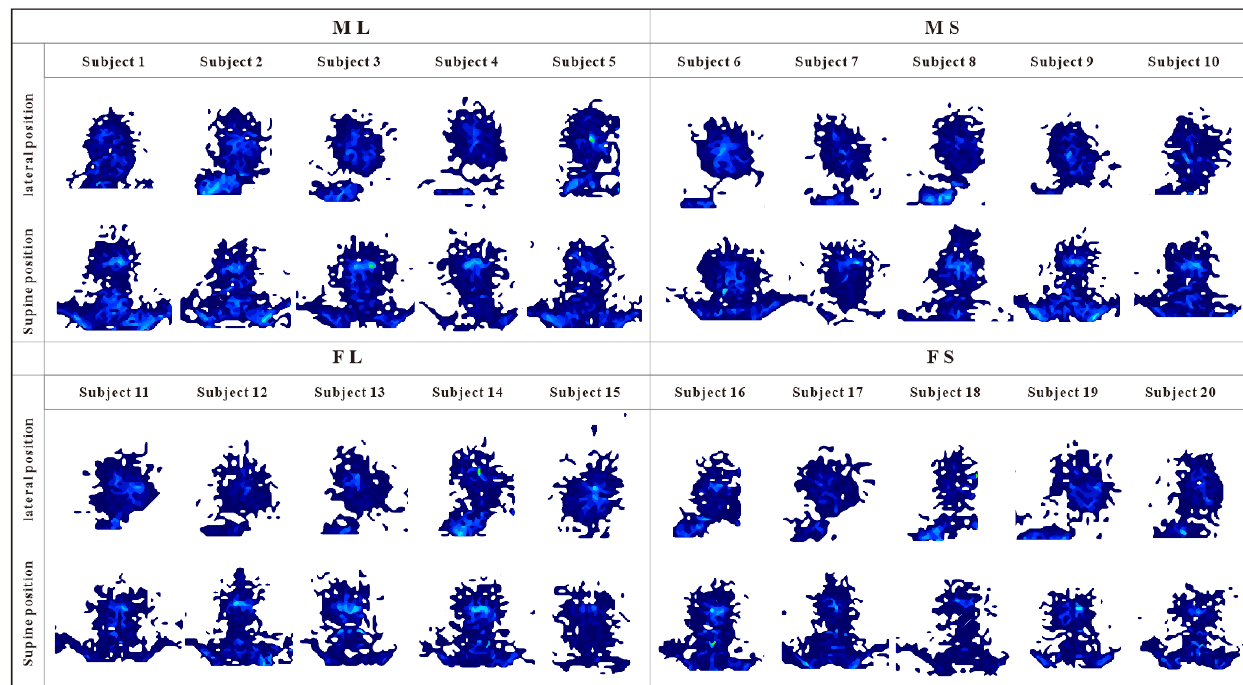
Figure 11. Pressure distribution diagram of prototype.